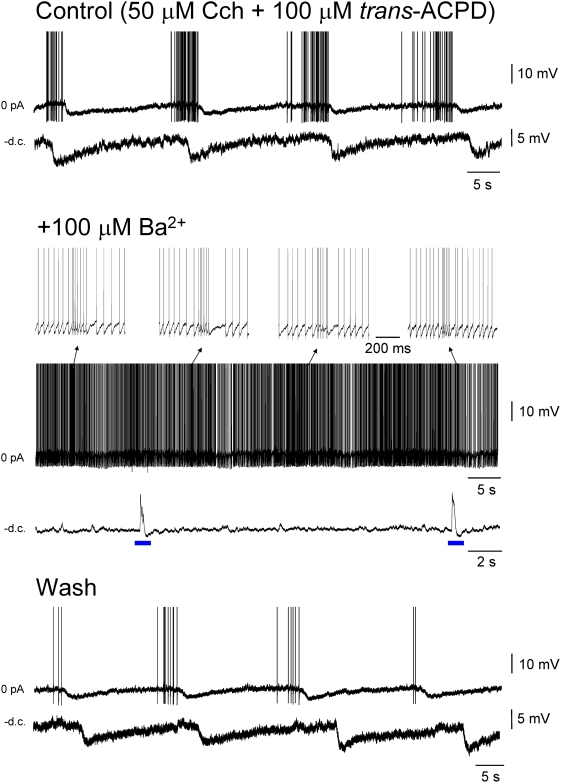
The long-lasting rhythmic hyperpolarizing potentials are blocked by Ba2+.Top panel: ISO recorded intracellularly in the LGN in the absence of steady injected current (top) and following the injection of a small amount of steady hyperpolarizing current (bottom). Middle panel: 100 µM Ba2+ abolishes the long-lasting rhythmic hyperpolarizing potentials that constitute the ISO. In the absence of steady inject current the neuron now exhibits continuous firing that is occasionally subject to short lasting (∼0.2–1 s) increases whereas when the cell is hyperpolarized it exhibits occasional brief depolarizing events (blue bars, average of five events shown below). Bottom panel: following washout of Ba2+, the neuron reverts to its original activity. (10 µM CNQX and 100 µM APV were present during this experiment and action potentials have been truncated in all panels).